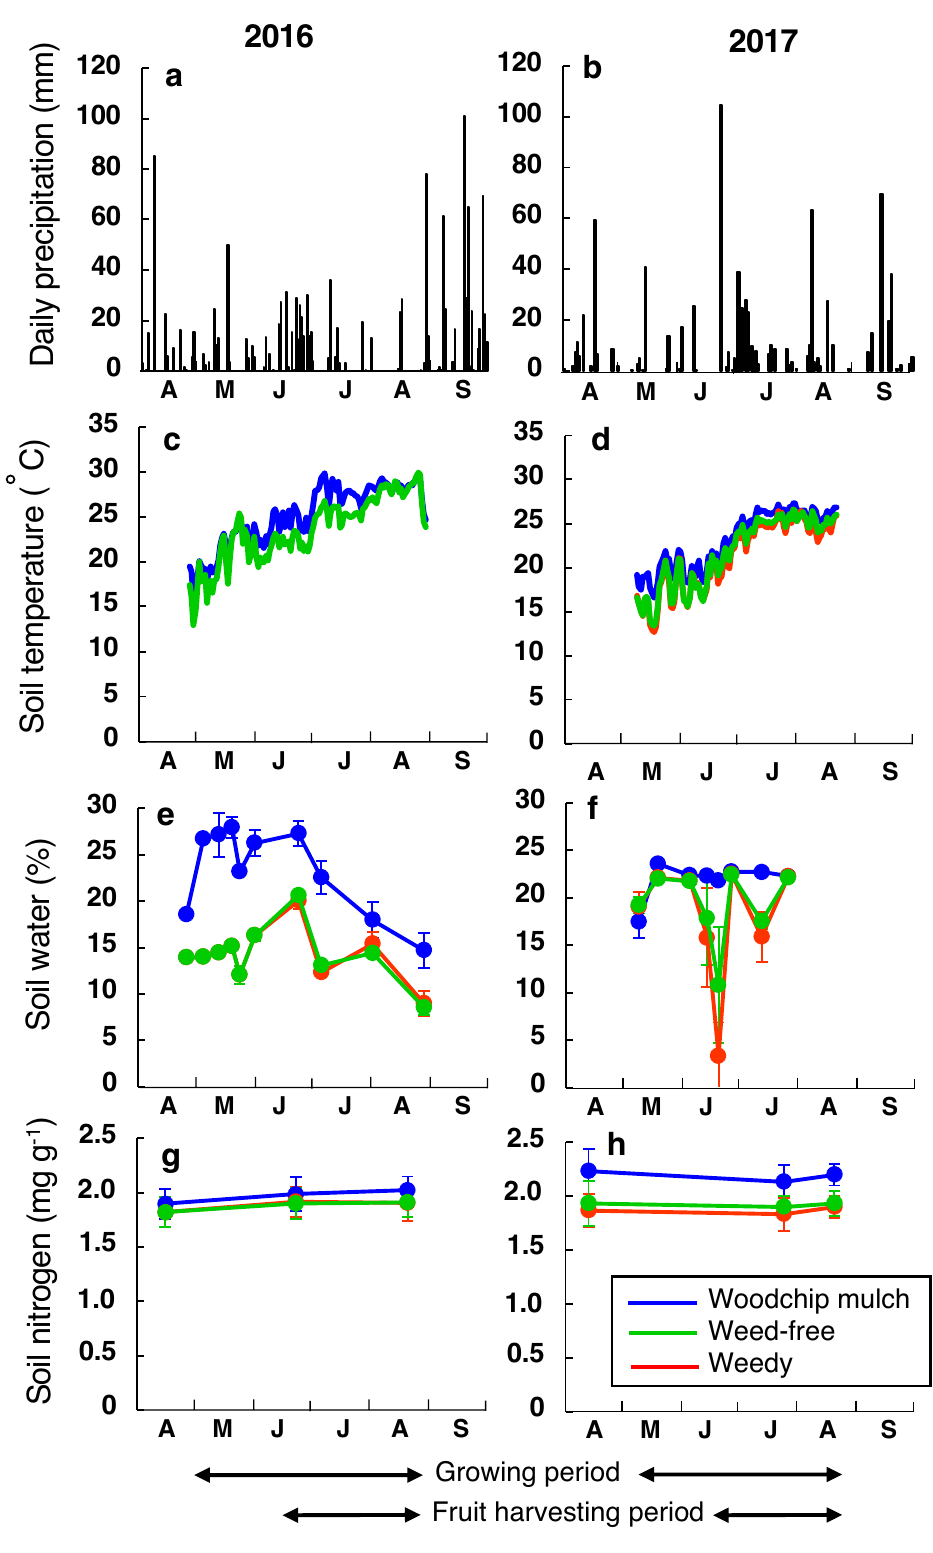
Figure 3. The seasonal changes in the microclimate. ( a , b ) Daily precipitation, ( c , d ) soil temperatures at 5 cm below the ground surface, ( e , f ) water contents in the soil from 0 to 10 cm below the ground surface (volume percentage), and ( g , h ) dry mass-based soil nitrogen concentrations from April to September in ( a , c , e , g ) 2016 and ( b , d , f , h ) 2017. The mean values in the woodchip mulch (blue), the weed-free (red) and the weedy (green) treatments are shown, and the error bars for soil water and nitrogen show ± 1 S.D. The growing period and fruit harvesting period in each year are shown by double-headed